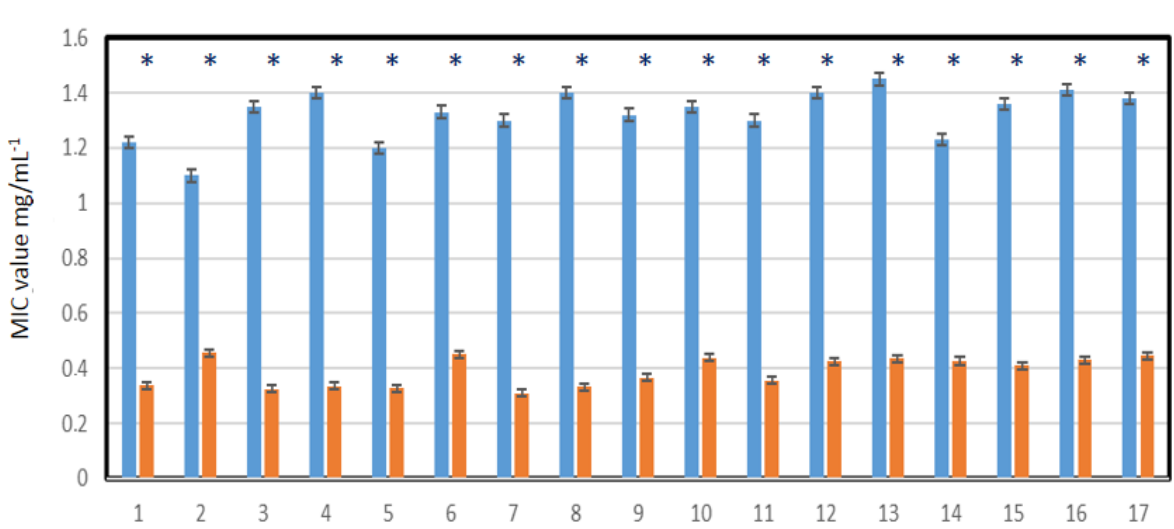
Figure 10. Virus particle analysis using MIC test (panel A- infected volunteers with SARS-CoV-2) and (panel B- infected volunteers after treatment of Salistat SGL03). Statistical significance vs. control in all analyzed samples were at * p < 0.05. X-axis number of study participants from 1 to